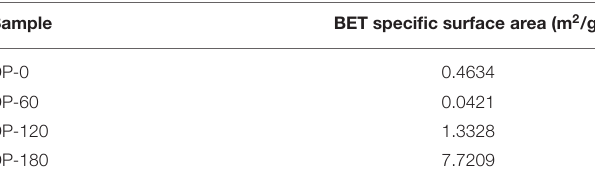
TABLE 2 | BET specific surface area of RPA in the DP-0, DP-60, DP-120, and DP-180 groups.